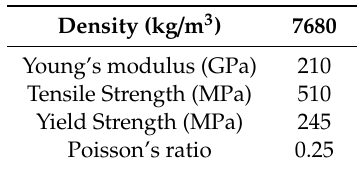
Table 1. Properties of SS400 low carbon steel.